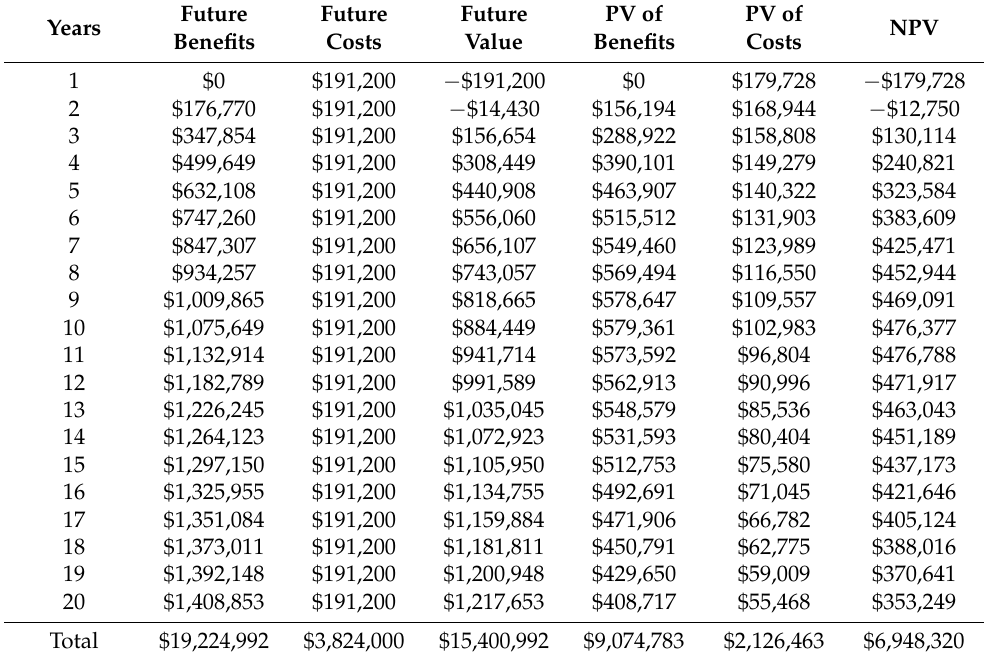
Table 2. Summary of the results of the benefit–cost analysis comparing an expanded vaccination control programme compared with a continuation of the current control programme.